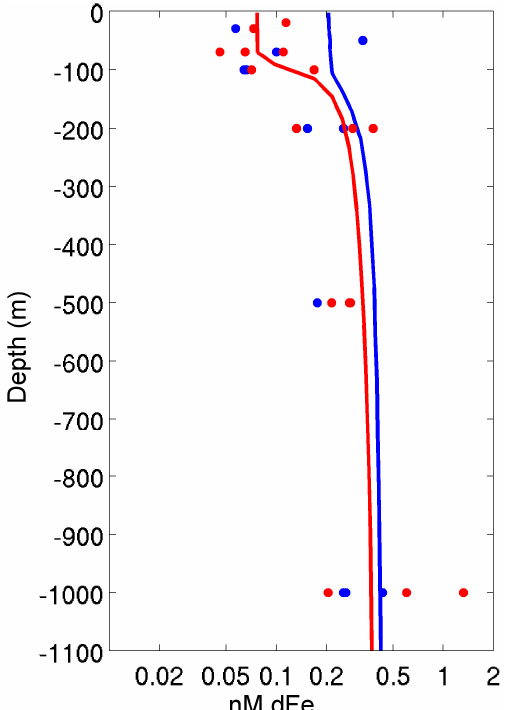
Fig. 8. DFe concentrations downstream (around 40.10 ◦ W, 52.86 ◦ S, in blue) and upstream (around 41.24 ◦ W, 55.21 ◦ S, in red) of South Georgia as from modelling results during November of the last modelling year (lines) and from observations reported by Nielsdóttir et al. (2012) during November 2006